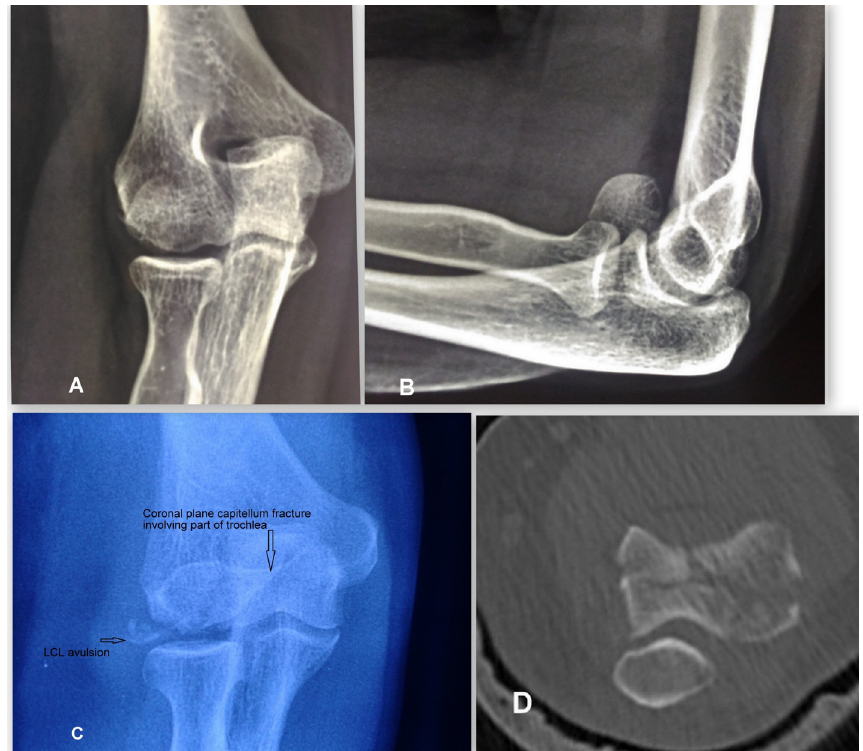
Figure 1. The different Dubberley fracture types. A and B (cid:1) Type 1 fracture. C (cid:1) Type 2 fracture. D (cid:1) Type 3B